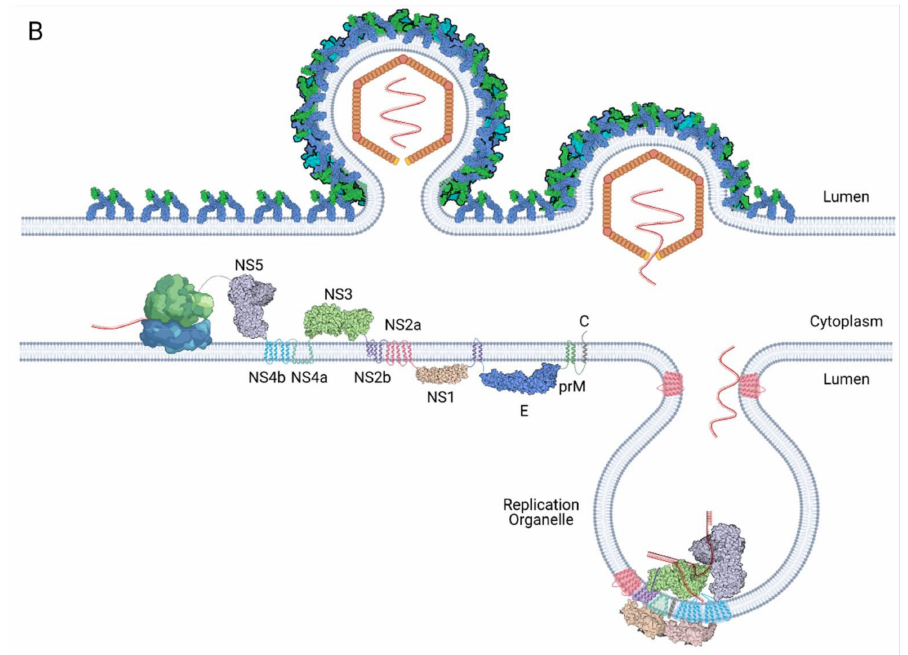
Figure 1. The flavivirus replication cycle. ( A ) Cartoon representation of the steps in the replication cycle, as detailed earlier in the section. ( B ) The translation and RNA replication step of replication are enlarged, showing the viral polyprotein, possible arrangement of the proteins in the complex, and the virion packaging mechanism. These steps require further study to fully elucidate how these structures assemble and function [15–21]. Created with